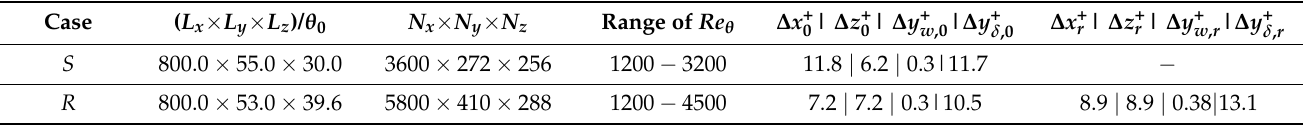
Figure 4. Streamwise variation of the normalized pressure gradient in the free stream: ( a ) normaliza- tion by θ 0 / ρ U 2 ∞ and ( b ) ν / ρ u 3 τ . Table 1. Details on the construction of the domain and grid resolution. The subscripts w and δ with ∆ y + imply the grid spacing at the wall and at local TBL height,